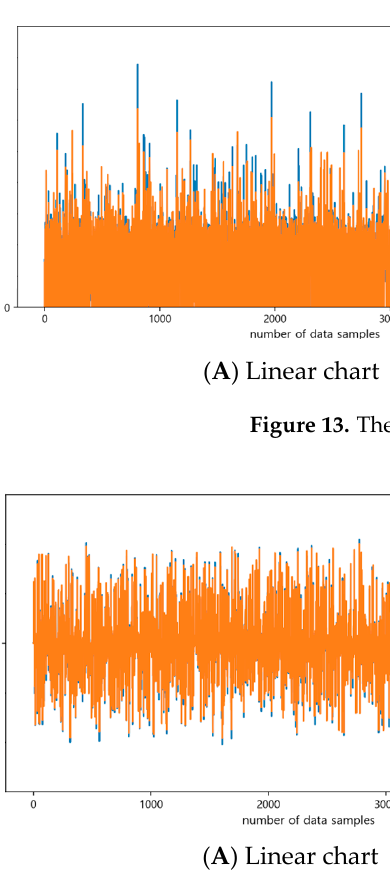
Figure 14. The predicted values of the valve seating velocity using the 1D-CNN model. Table 5. A performance comparison of prediction models for valve train force prediction.